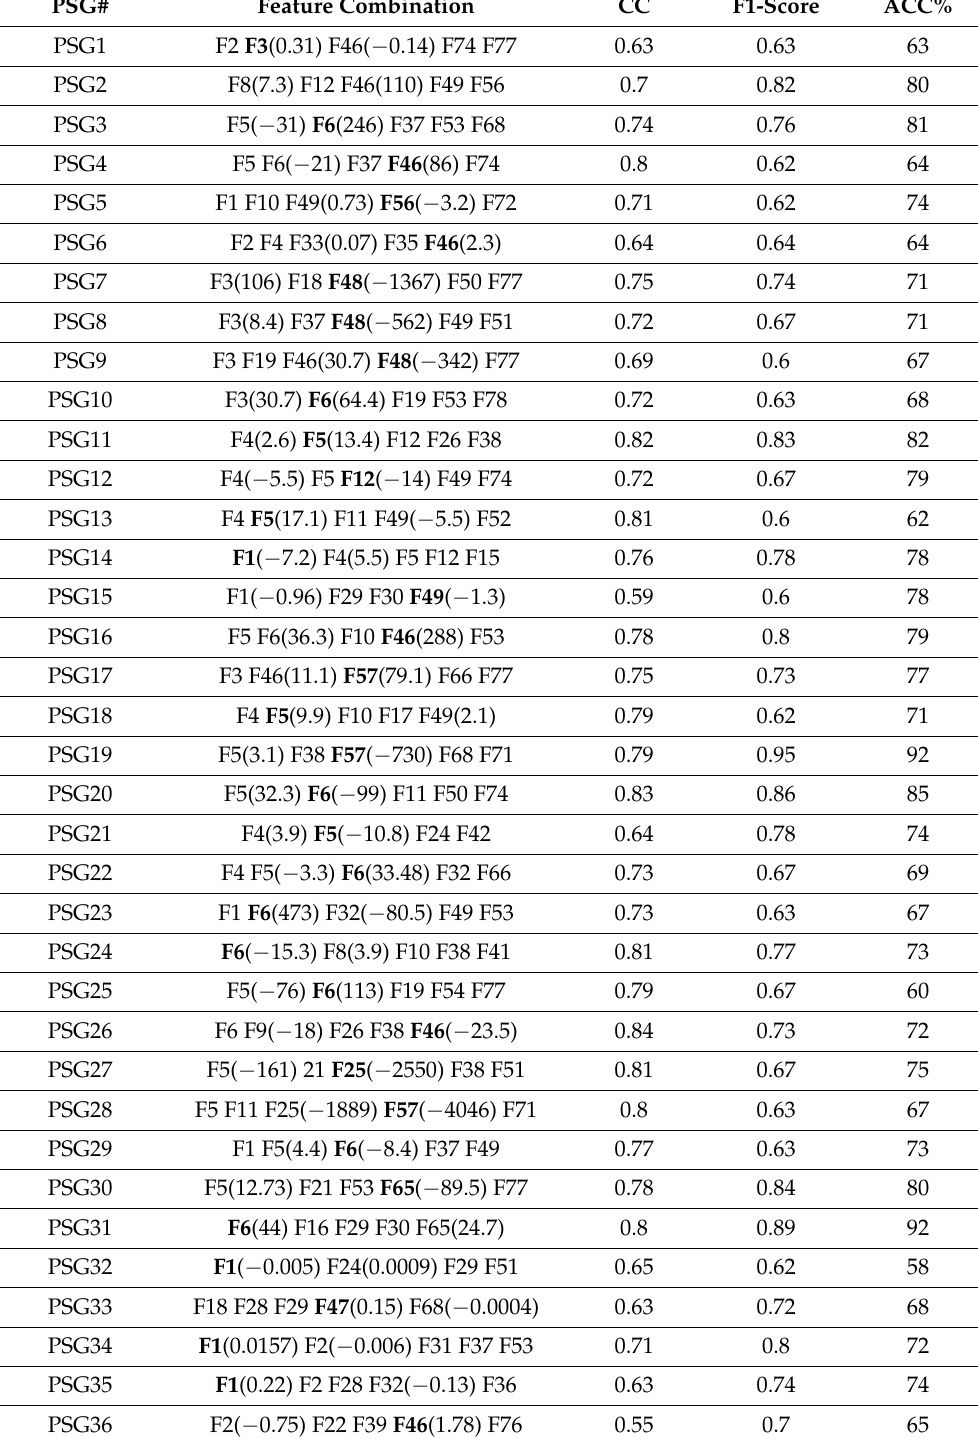
Table 4. The correlation coefficients between the PSG parameters and the outcomes of the bilinear model for the entire dataset, as well as their blind testing F1 scores and classification